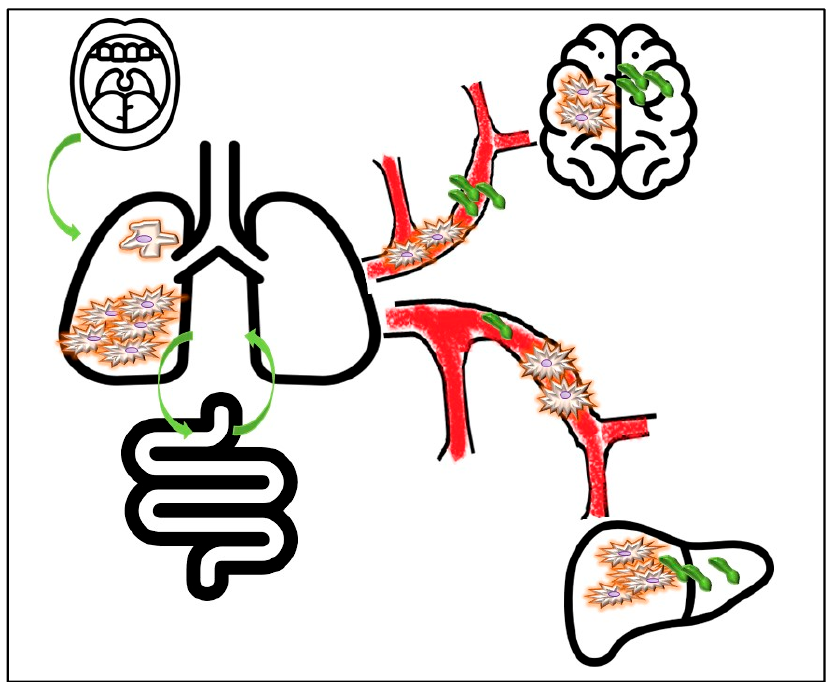
Figure 1. Lung cancer and microbes. Lung cancer microbiota (intratumor microbiome) composition is strictly influenced by oral cavity microbes and by the so-called gut – lung axis. Circulating and metastatic microbial signatures can be detected as well. Moreover, the microbiome also identifies an important compartment of tumor microenvironment (peritumoral and stromal microbiome), and a cross-talk exists between bacteria and cancer cells, which reciprocally influence each other with diagnostic and therapeutic